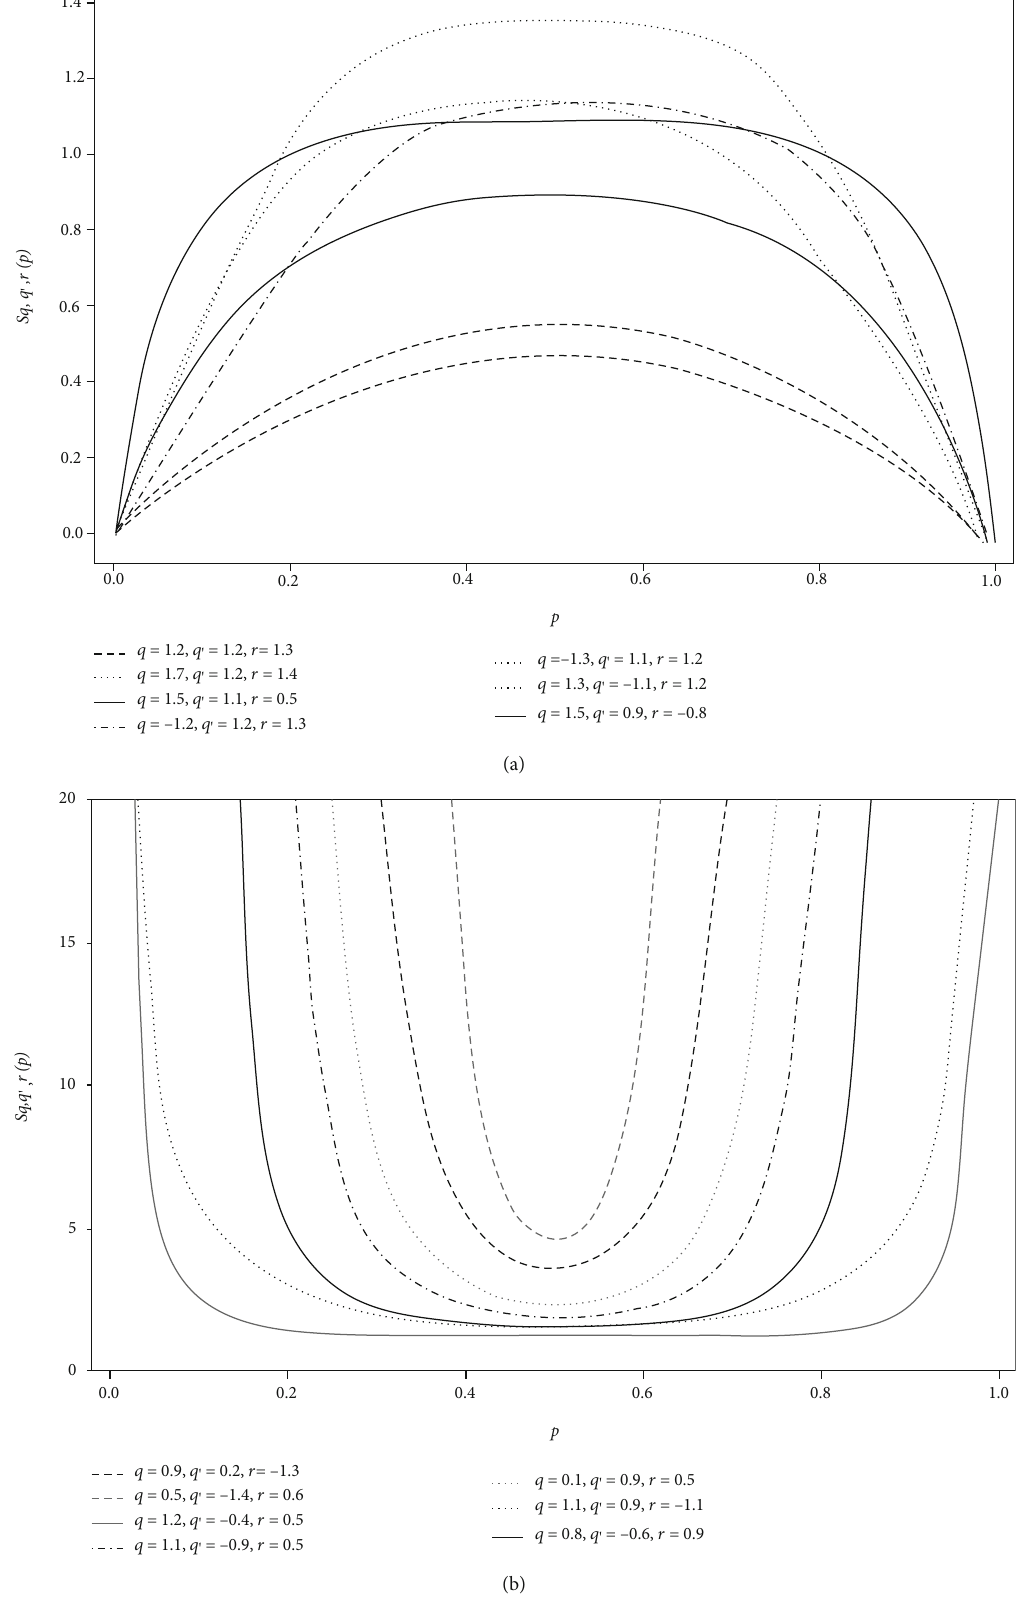
Figure 3: Illustration of the three-parameter entropic function: (a) concavity and (b)